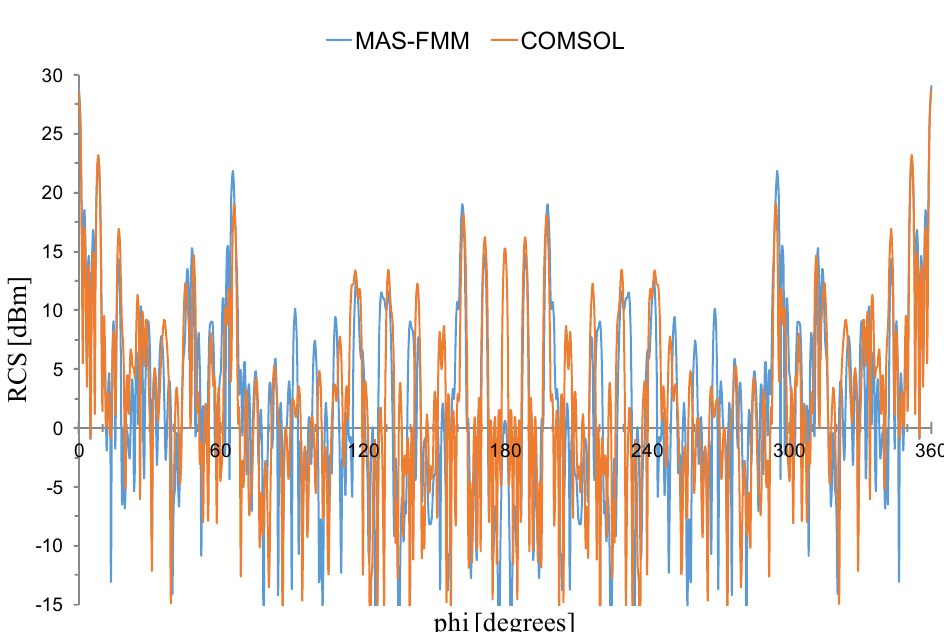
Figure 7. RCS (in dBm) as a function of the observation angle in the azimuth plane for a 5 × 5 lattice of cylinders. The parameters pertaining to the cylinders and the incident field are provided in Table 1. The results were obtained from MAS-FMM and COMSOL.